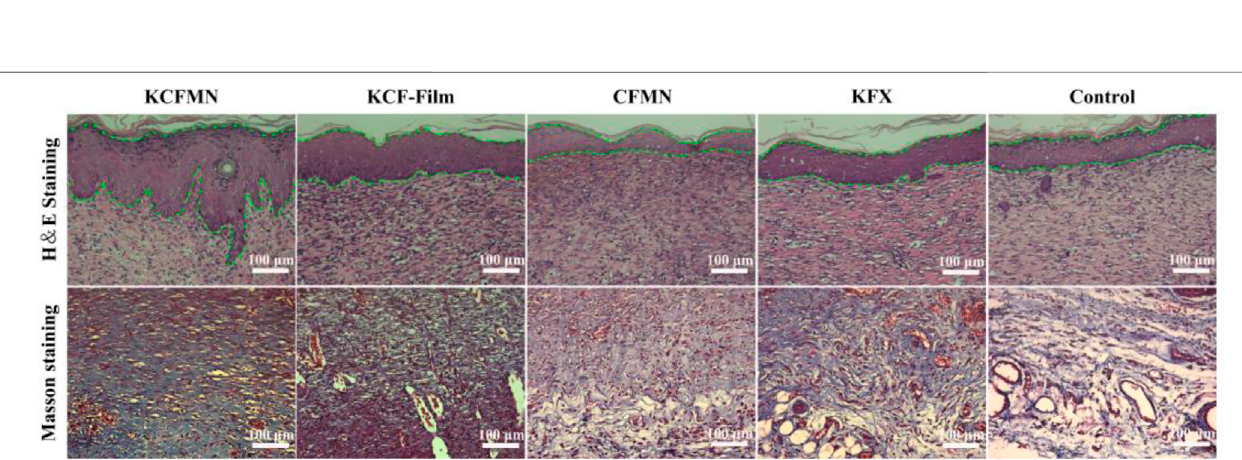
Frontiers in Chemistry |